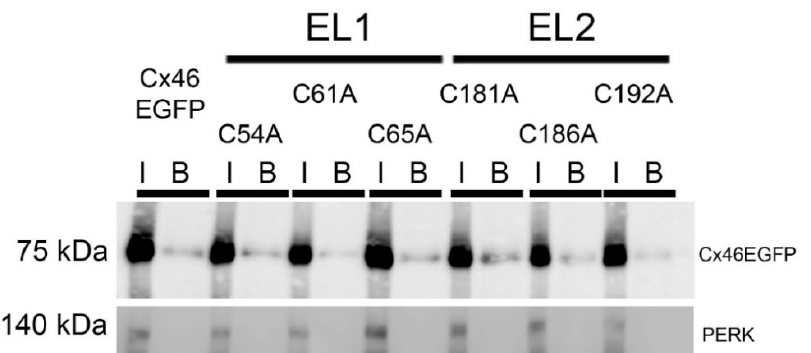
Figure 3. Cys mutants are present at the plasma membrane. Cell-surface biotinylation was performed in cultures of HeLa cells transfected with wild-type Cx46 or Cys mutants, and samples were then analyzed by Western blotting. I (Input): 50 µ g of protein before the separation with streptavidin-magnetic beads; B: the whole sample after the separation with streptavidin-magnetic beads. The presence of the cytoplasmatic protein PERK was used as negative control and, as expected, was found only before separation and not in the biotinylated sample. ( n = 3 independent experiments).